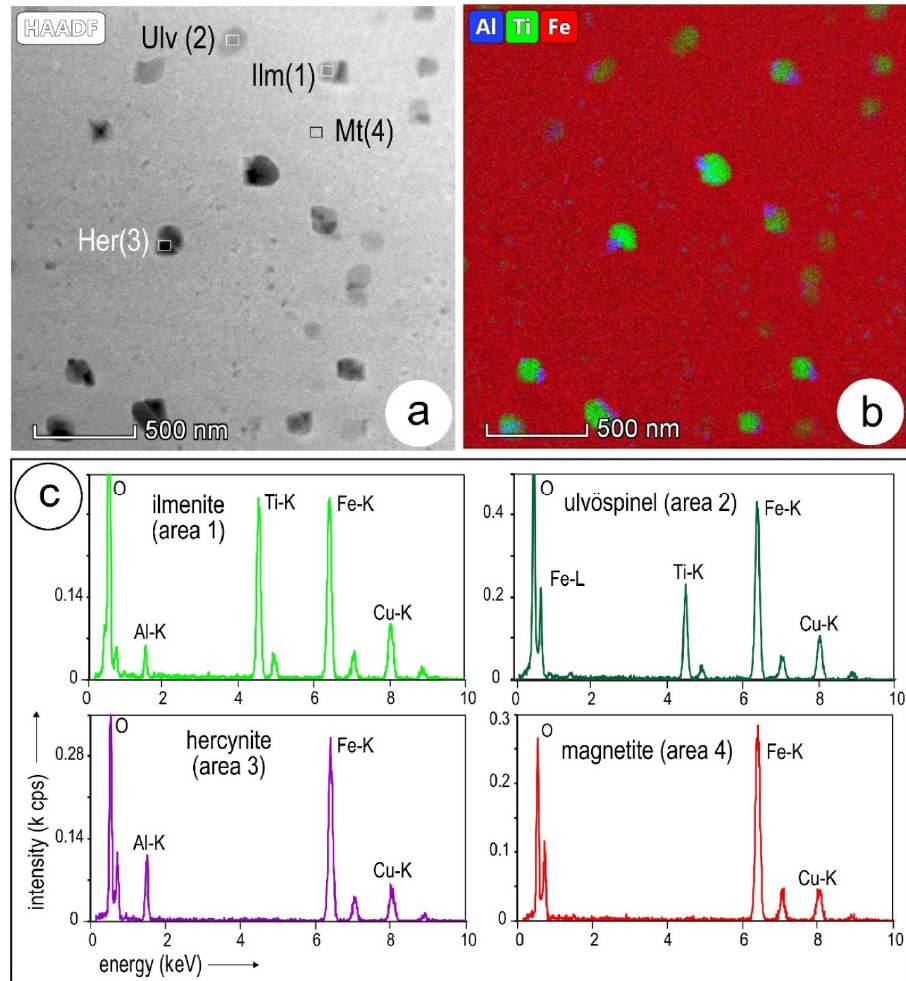
Figure 11. HAADF STEM image ( a ), STEM-EDS maps ( b ) and spectra for bleb-like inclusions and host magnetite (Mt) ( c ) typical of magmatic magnetite from least-altered RDG (location #5; foil #8). (a) Mottled texture with inclusions of two sizes, fine particles and nanoparticles. (b) Overlap between Al, Ti and Fe maps showing the coarser blebs are Ti- and Al-bearing (binary inclusions). (c) Spectra of inclusions and host magnetite obtained from areas marked in (a). Note the presence of ulvöspinel (Ulv) in some of the blebs (lower HAADF signal intensity in (a)). This shows the inclusions comprise two compositionally distinct spinels, Ti- and Al-bearing, respectively, associated with ilmenite (Ilm). Note that the host magnetite does not contain measurable Ti or Al. The Cu signal is from the TEM grid. Her ⸺ hercynite.